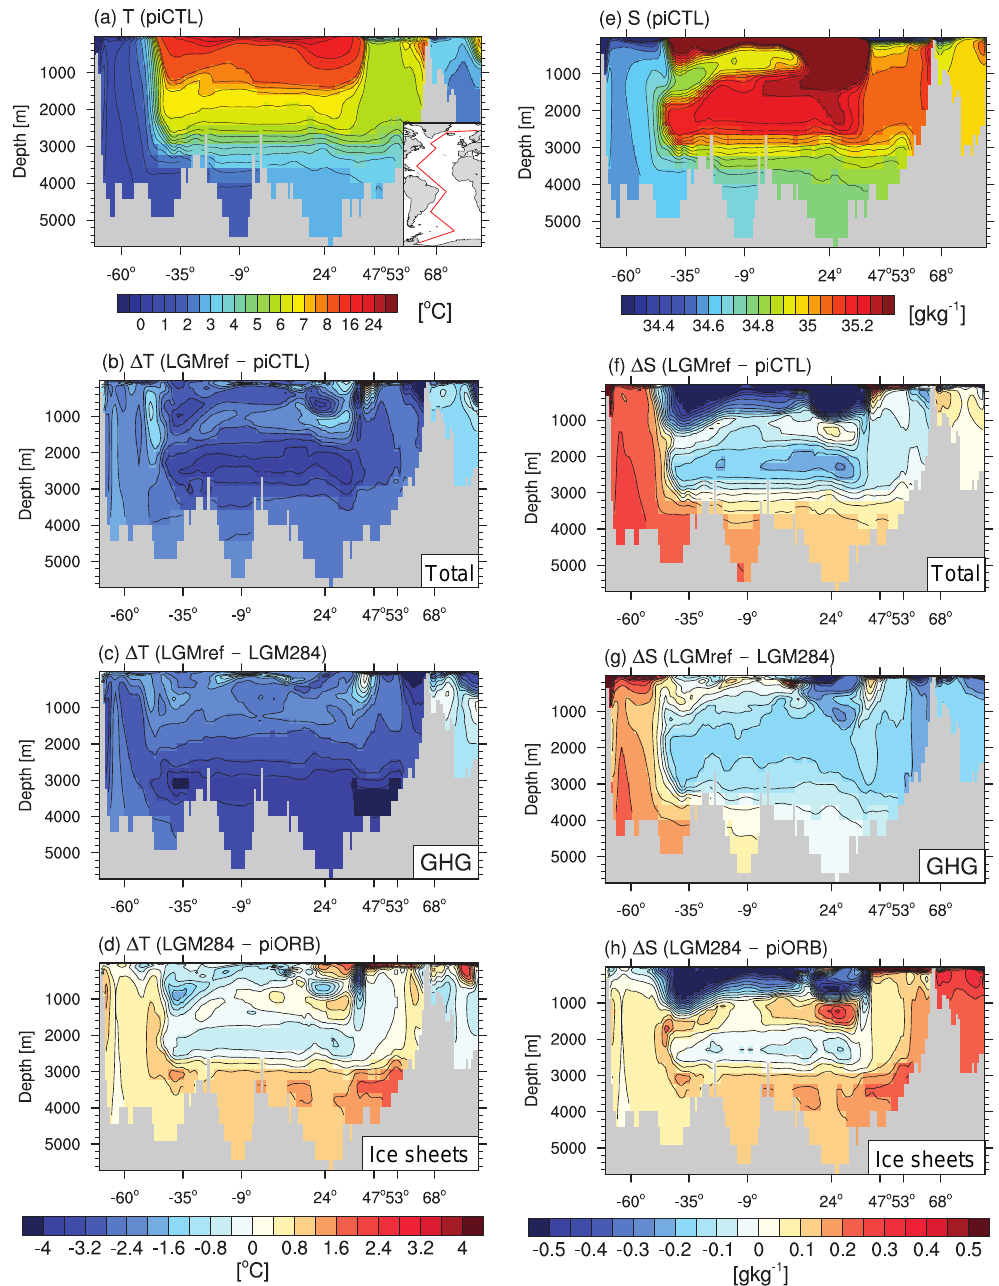
Figure 5. Transect through the Atlantic. (a–d) From top to bottom: potential temperature in piCTL and temperature changes due to the total glacial forcing (LGMref – piCTL), the glacial GHG concentrations (LGMref – LGM284) and the ice sheets (LGM284 – piORB). (e–h) Same as left column but for salinity. Before calculating the differences, the salinity of piCTL and piORB has been increased by 1.21gkg − 1 for comparison with the GHG induced differences (LGMref – LGM284). A map of the transect is shown in (a)